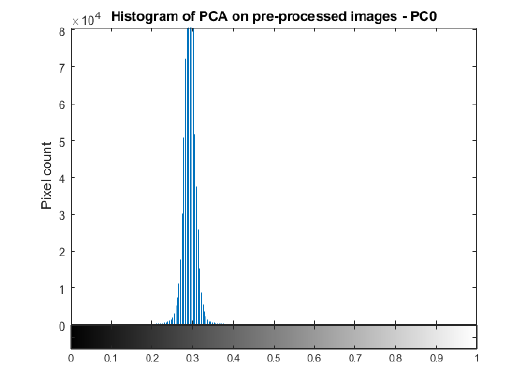
Figure 8. Histogram of normalised C 0 from PCA on pre-processed images.